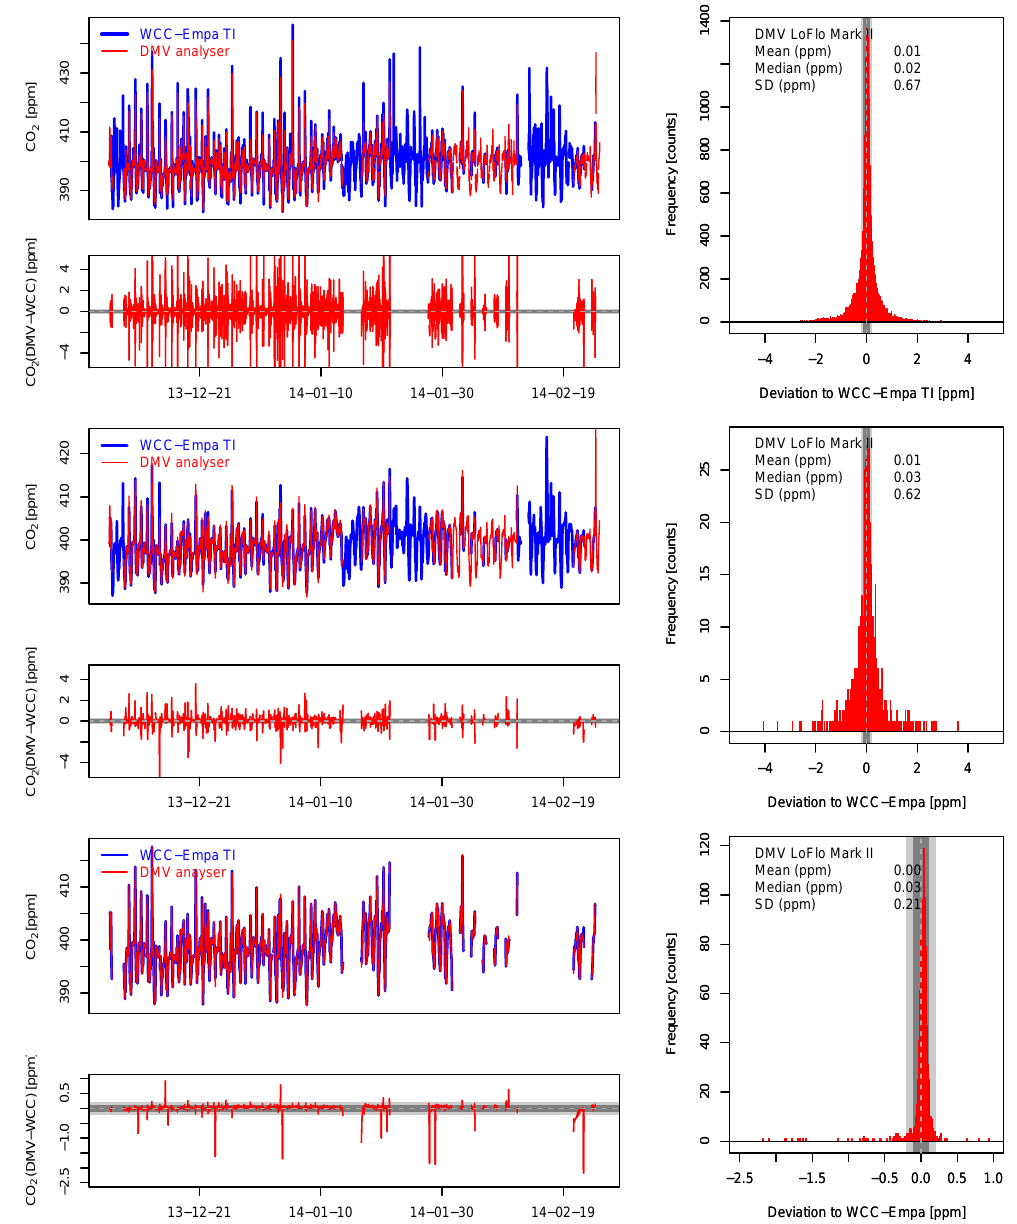
Figure 7. CO 2 comparison at DMV between the WCC-Empa travelling instrument and the DMV LoFlo Mark II instruments. Left: CO 2 time series and CO 2 bias vs. time. Right: deviation histogram. Upper set: 1min data; middle set: 1h data, calculated from all available 1min values; lower set: 1h data, calculated from 1min values with both DMV and WCC-Empa data coverage. The grey areas correspond to the WMO/GAW compatibility (dark grey) and extended compatibility (light grey)